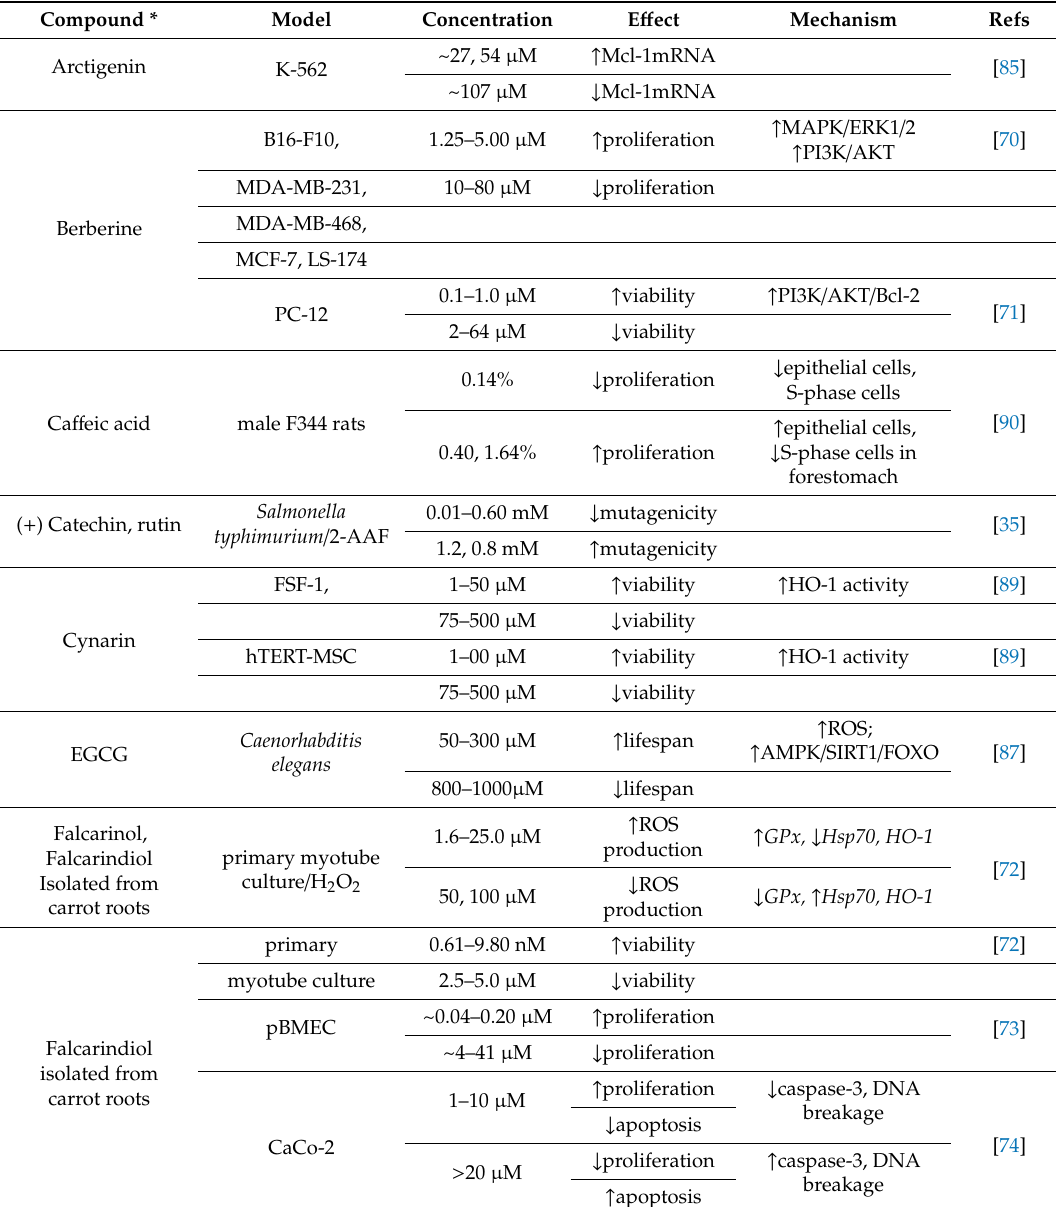
Table 3. Table 3. Phytochemicals exhibiting biphasic concentration /